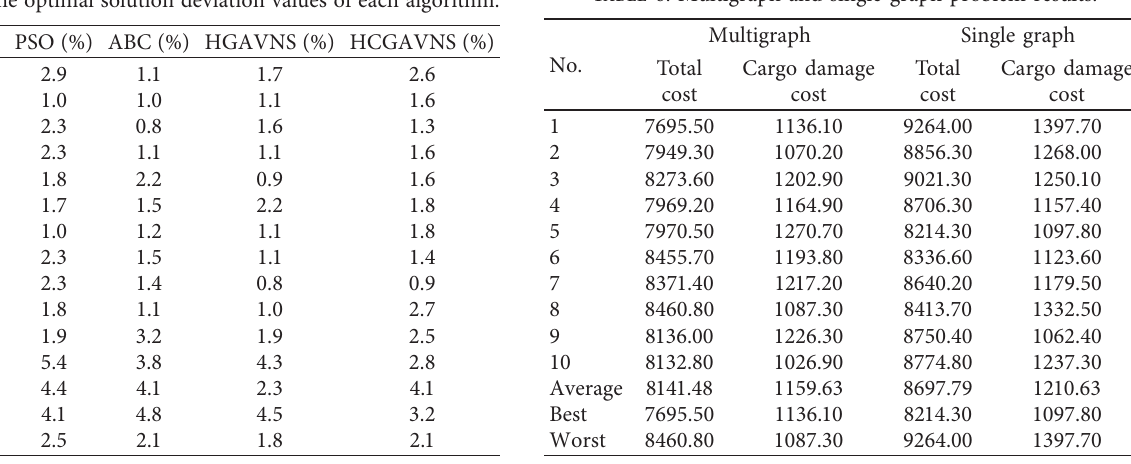
Table 5: The optimal solution deviation values of each algorithm. Table 6: Multigraph and single-graph problem